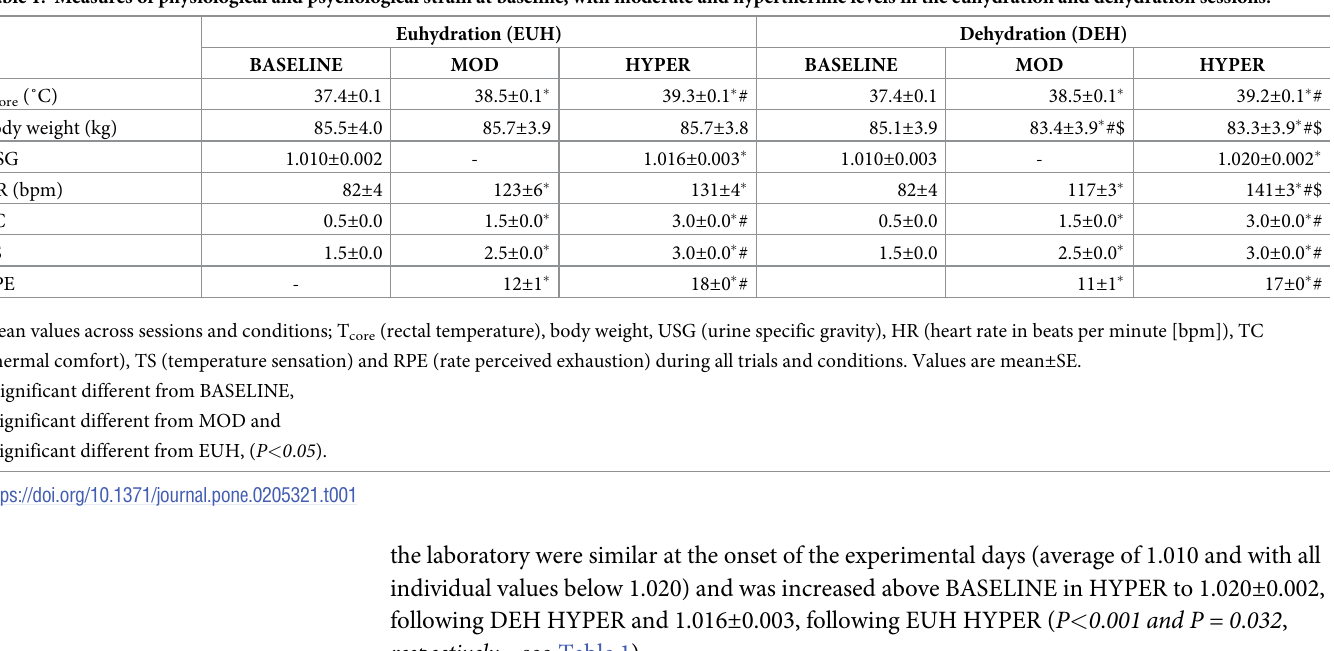
Table 1. Measures of physiological and psychological strain at baseline, with moderate and hyperthermic levels in the euhydration and dehydration